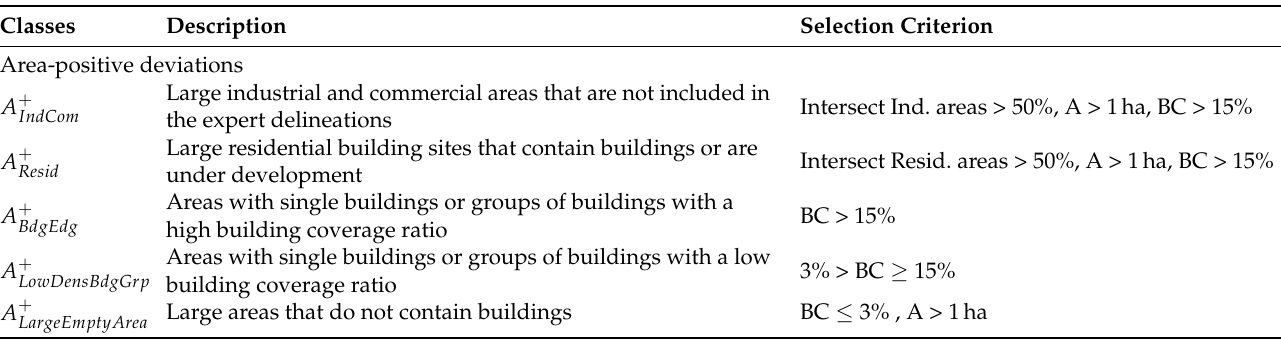
Figure 9. Classes of area-negative deviations ( source : own compilation based on data from official building polygons, ATKIS ® Base-DLM © Geobasis-DE/BKG (2017), Planning Information System of the Joint State Planning Department Berlin/Brandenburg). Table 2. Classes of